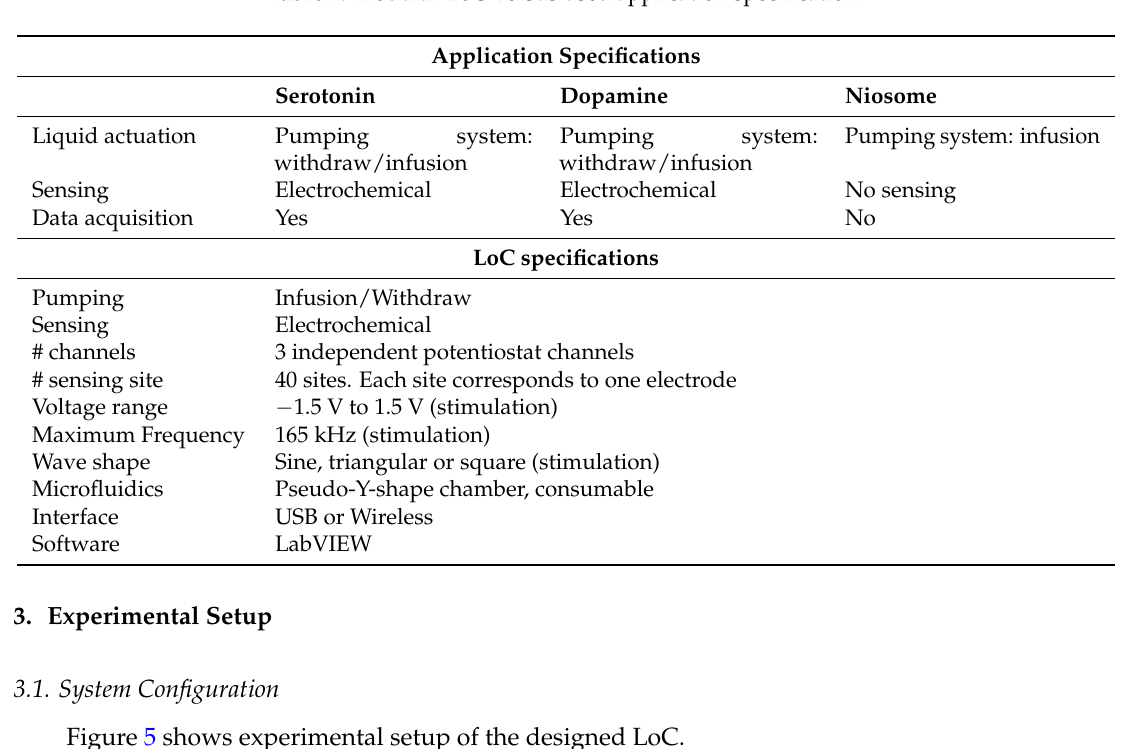
Table 1. Modular LoC versus used application specification.